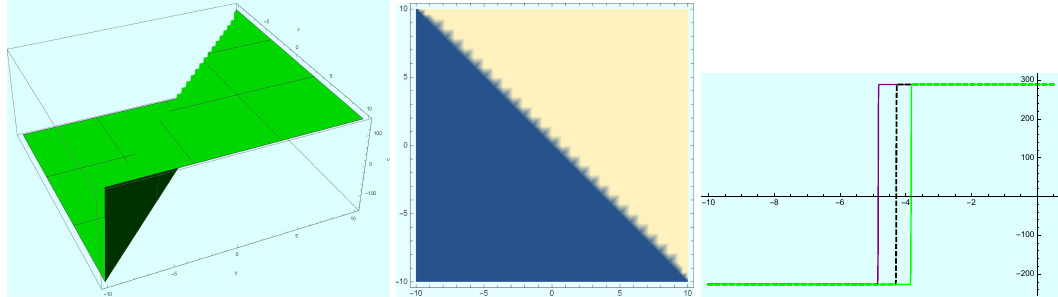
Figure 6. Evolution of traveling wave of singular soliton solution (24) at t = − 0.2 and z = 20.